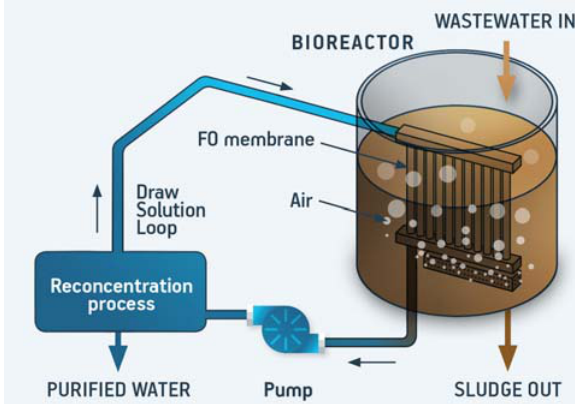
Figure 7. Schematic representation of an OsMBR.